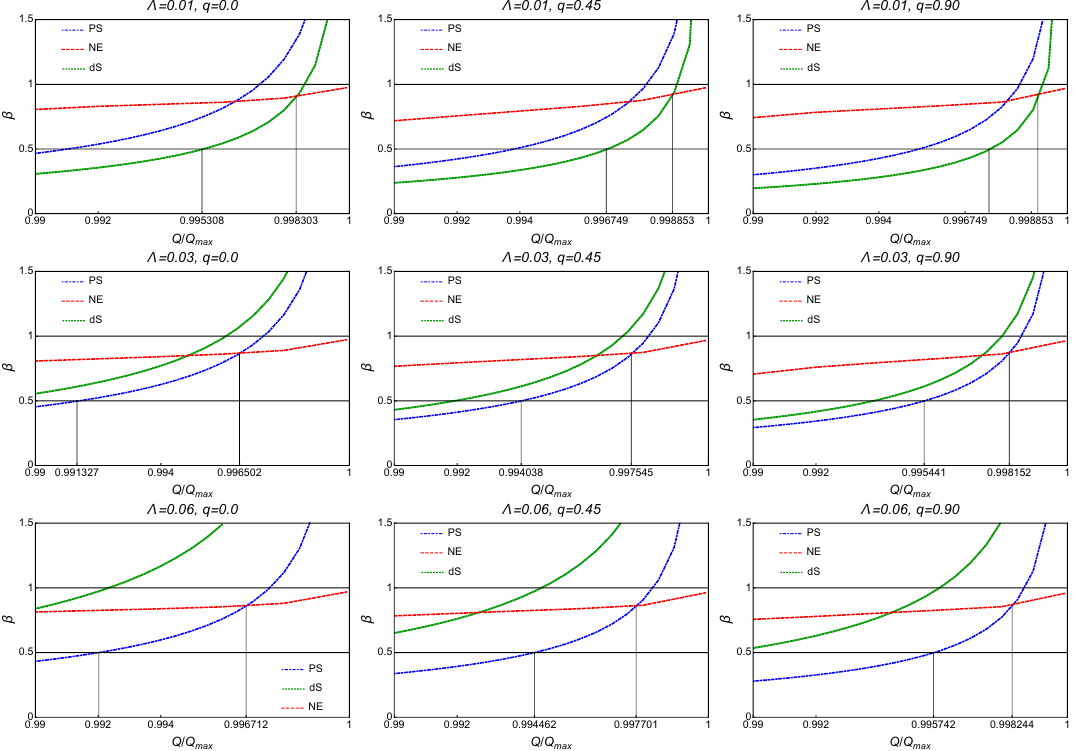
Figure 1 . The variation of (cid:12) constructed out of the imaginary part of the quasi-normal mode with ( Q=Q max ) has been presented for di(cid:11)erent values of the cosmological constant and tidal charge parameter q inherited from higher dimensions (for a (cid:12)xed (cid:11) = 10 (cid:0) 5 ). The photon sphere modes (drawn for ‘ = 10) are presented by blue dashed line, while the de Sitter (drawn for ‘ = 1) and the near extremal modes (drawn for ‘ = 0) are depicted by green dashed and red dashed line respectively. The plots for (cid:12) (cid:17) (cid:0) (Im !=(cid:20) (cid:0) ) explicitly demonstrate that as the tidal charge parameter q increases, for a (cid:12)xed (cid:3), the violation of strong cosmic censorship conjecture happens at higher and higher values of Q=Q max . On the other hand, for a (cid:12)xed q , the de Sitter modes dominate for small values of the cosmological constant, while the photon sphere modes dominate as value of cosmological constant increases. In each of these plots, the (cid:12)rst black vertical line corresponds to the value of ( Q=Q max ) where strong cosmic censorship conjecture is violated and the second vertical line presents the location of ( Q=Q max ), where near extremal modes starts to dominate over and above the de Sitter/photon sphere modes. Note that always the near extremal modes starts to dominate before (cid:12) reaches